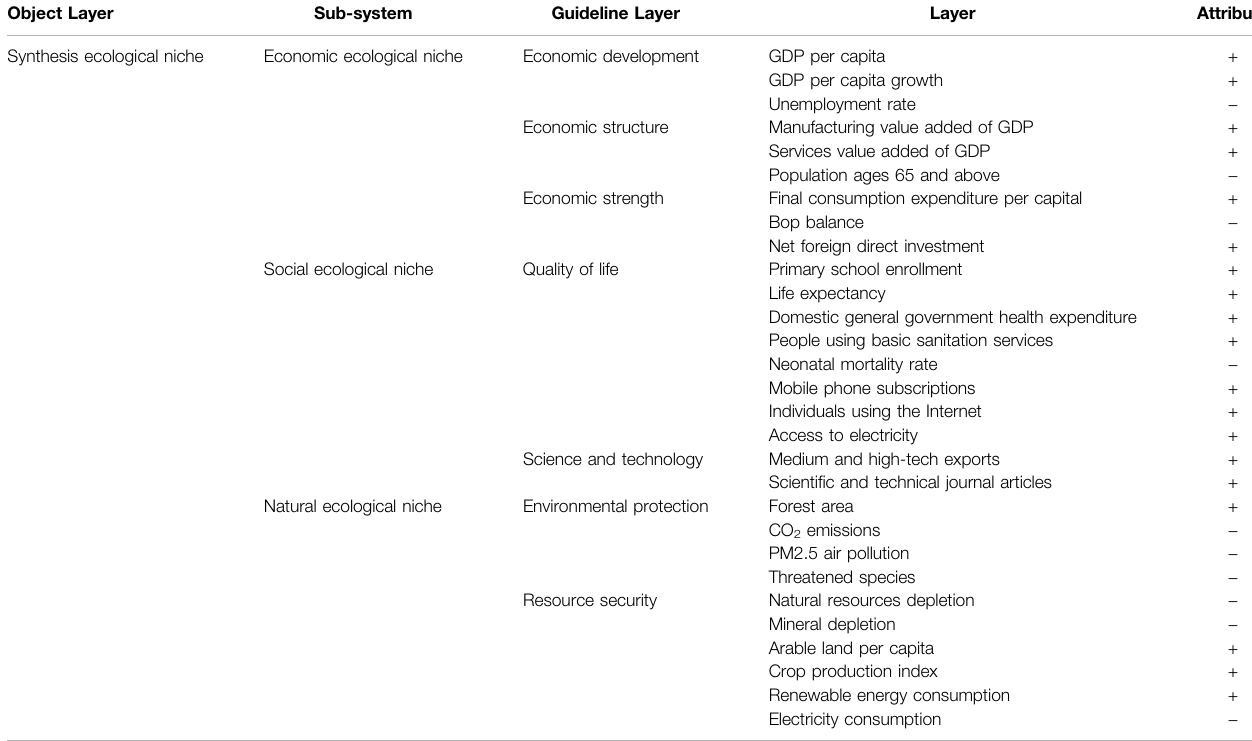
TABLE1| Constructedindicatorsystemforassessingecologicalnichesincomplexecosystemsisshowninthetable.The “ + ” referstopositiveindicators,andthe “ − ” refers to negative indicators. As explained in the paper, positive and negative indicators are treated differently when normalizing the